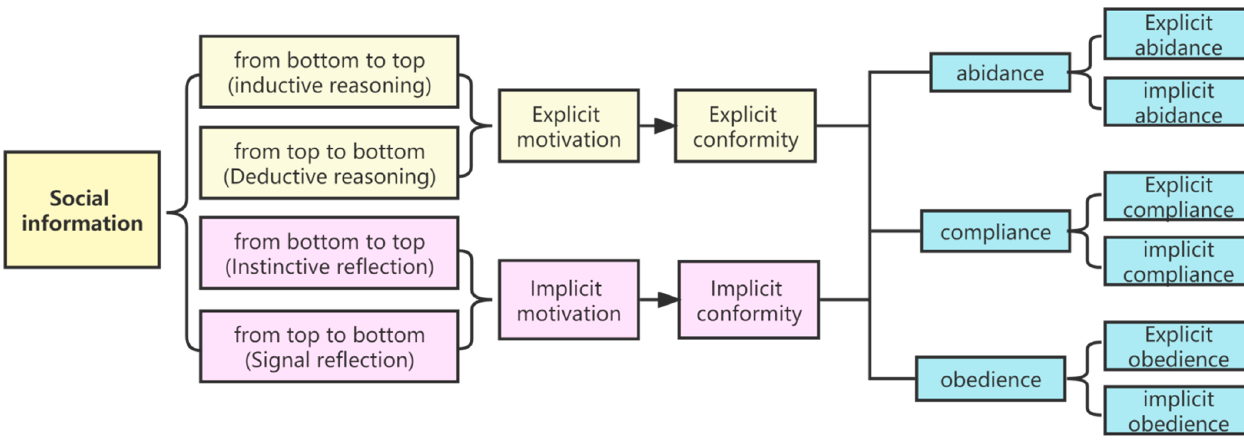
Figure 2. Processes involved in Information processing and types of internal attribution.